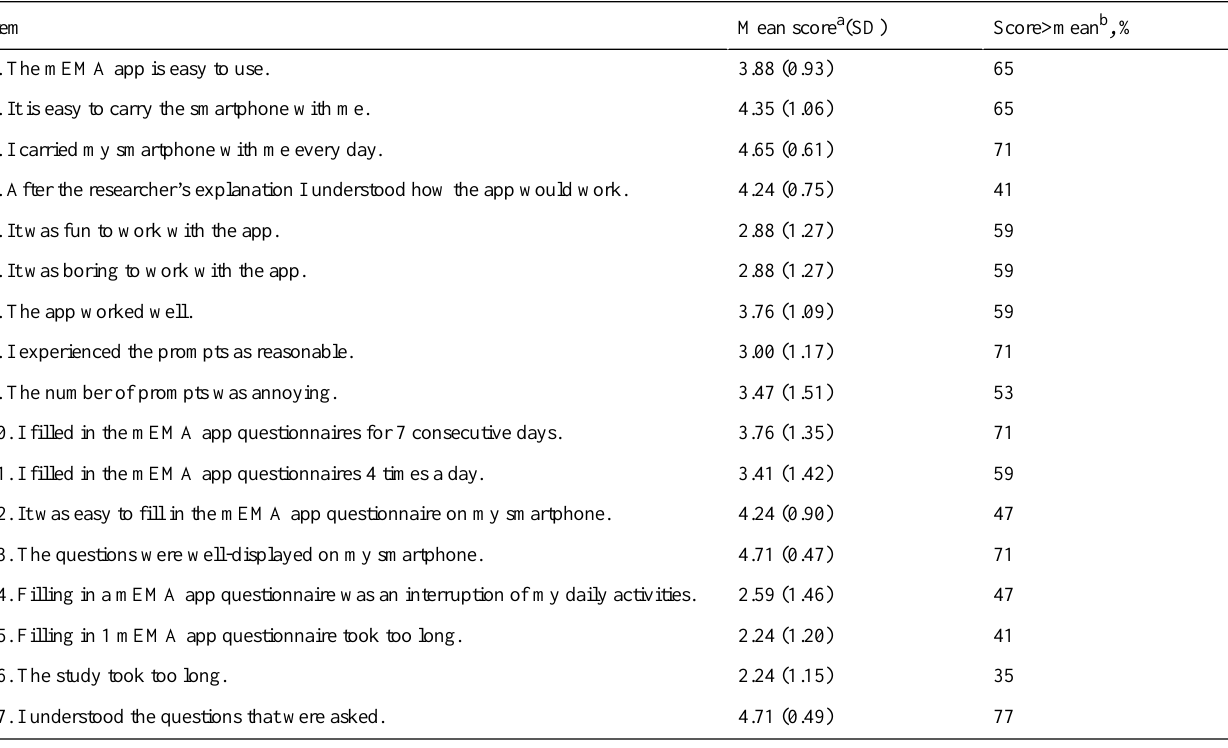
Table 1. Feasibility and usability measures